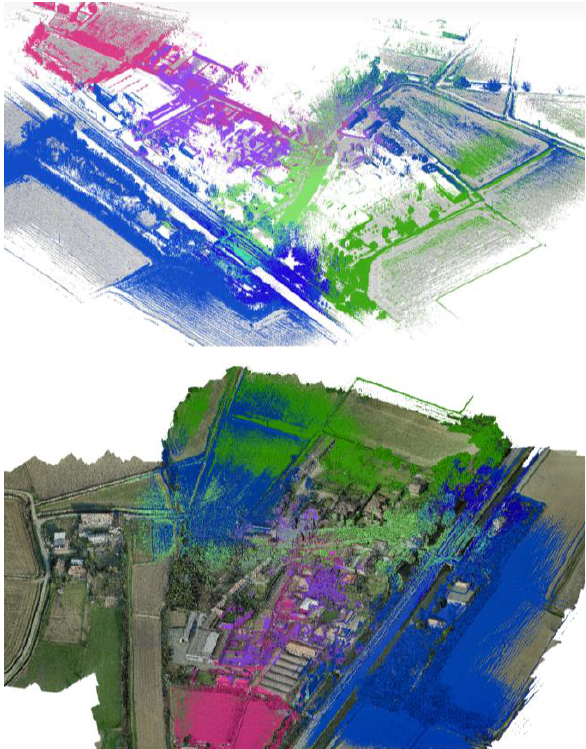
Figure 6. Above: five different and merged MLS point clouds without RGB data. Below: the final point cloud made from the integration between MLS and UAV